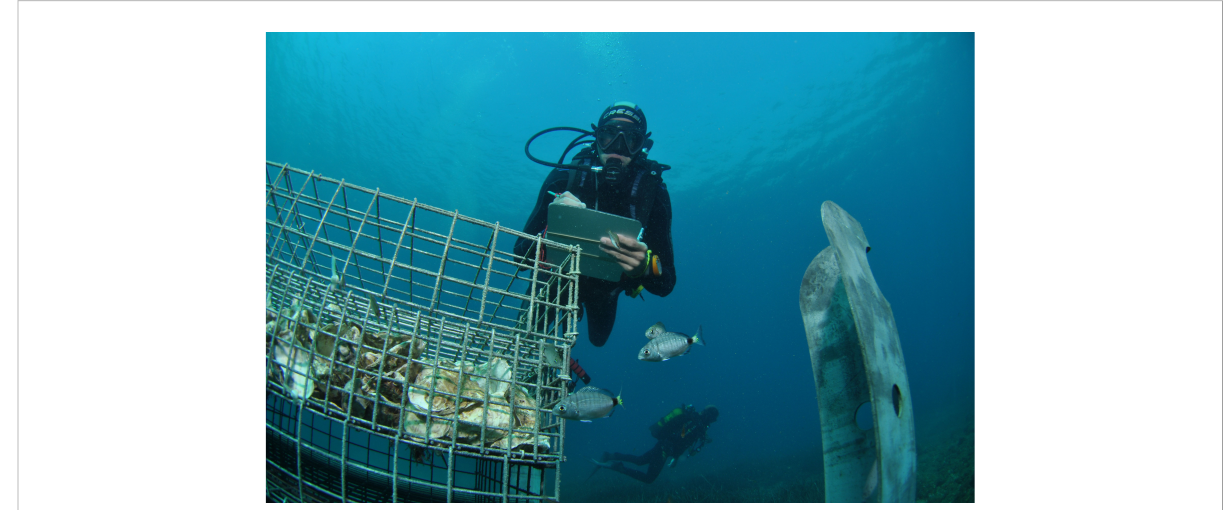
FIGURE 3 Monitoring survival of tagged and released Diplodus sargus with underwater visual surveys. Photo: © Re ́ my